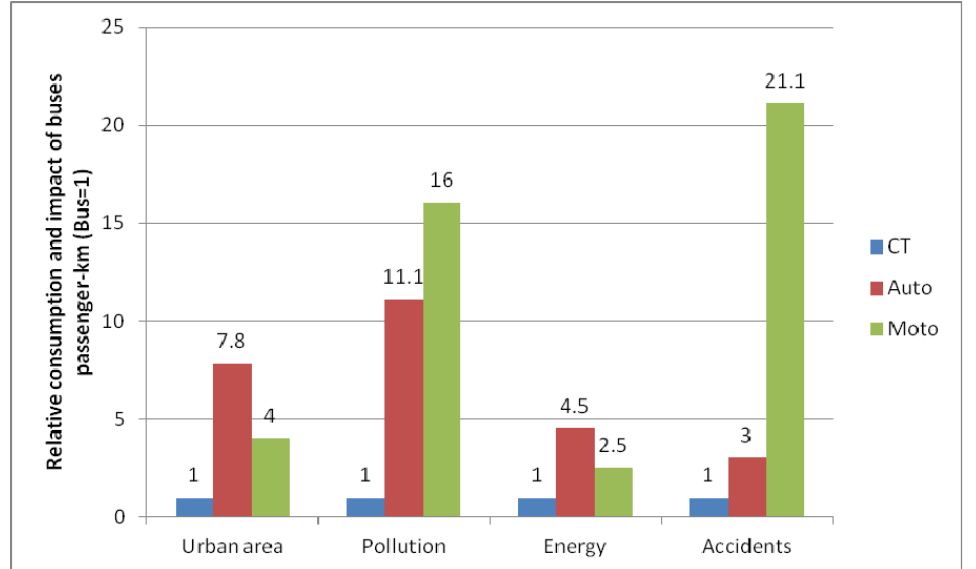
Figure 8. Relative consumption and impact of the use of buses, motorcycles and cars in Brazilian cities (Bus value = 1). Source: ANTP